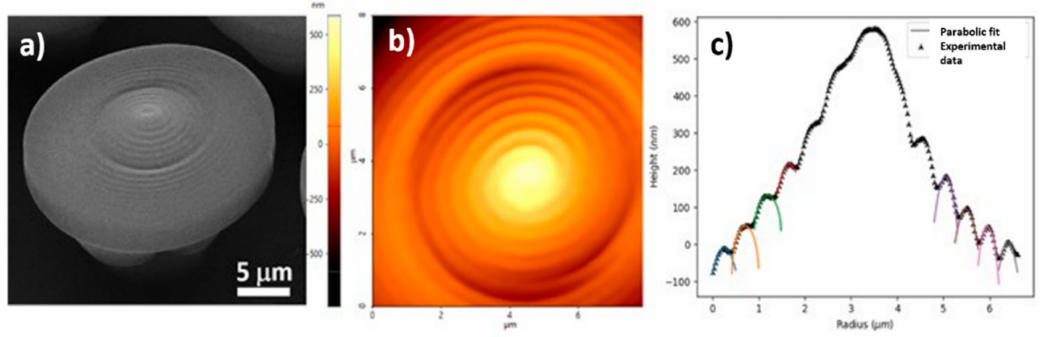
Figure 6. ( a ) Scanning electron micrograph (SEM) of a nanostructured mushroom-like pillar (NMP) inclined at 30 degrees; ( b ) Atomic force microscopy (AFMJ) image of NMP from ( a ); ( c ) Cross-section of the indentation surface through the center of a mushroom-like pillar (star-like points: experimental data; continuous lines: parabolic